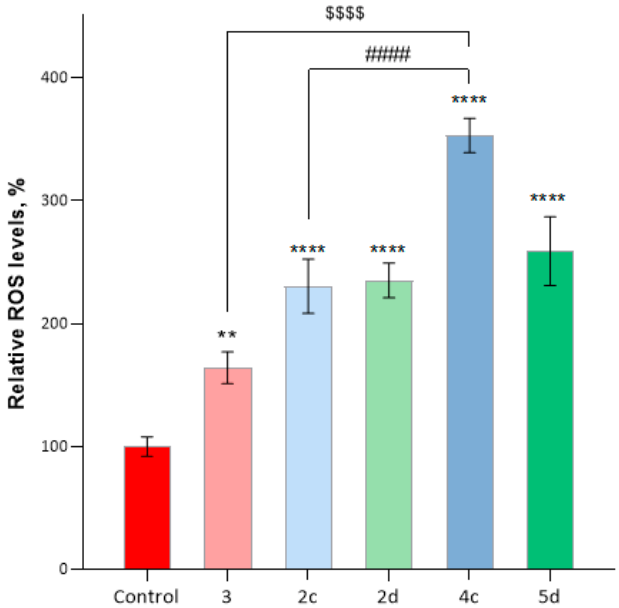
Figure 4. Induction of ROS production by compounds 2c , 2d , 3 , 4c and 5d . The data were obtained with flow cytometry and the CellROX ® Deep Red kit. Concentration for compounds was equivalent to IC 50 cytotoxicity on M-HeLa cells. Data are presented as mean ± SD ( n = 3). ** p < 0.01, **** p < 0.0001 compared to control; #### p ≤ 0.0001, compared to 2c ; $$$$ p ≤ 0.0001 and compared to 3 (one-way ANOVA).